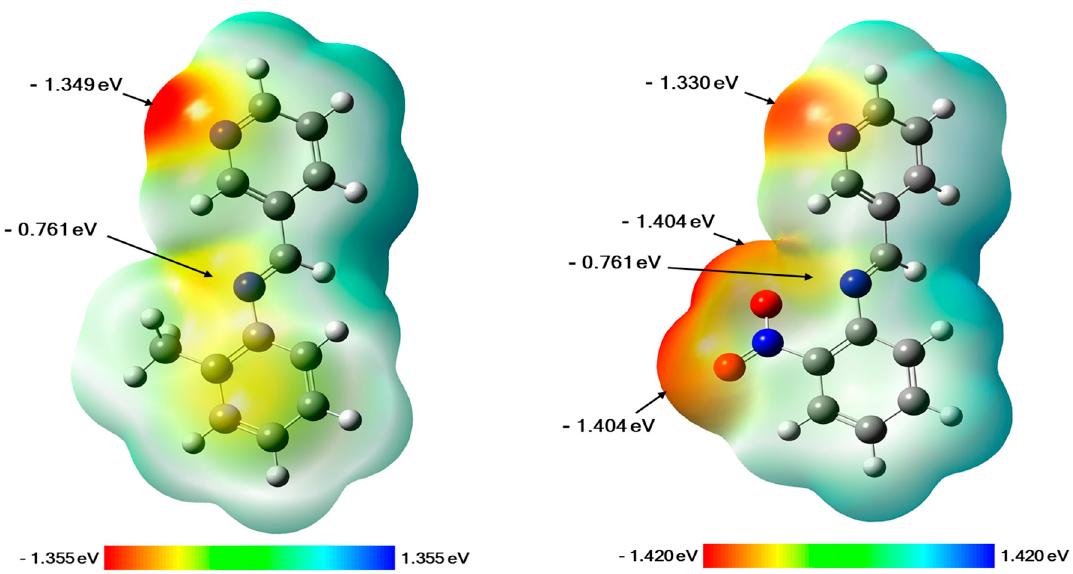
Figure 1. Generated molecular electrostatic potential (MEP) maps of compound 2 ( left ) and compound 3 ( right ). The negative (red, orange, and yellow) regions are related to electrophilic reactivity, whereas positive (green and blue) regions accompany nucleophilic reactivity.